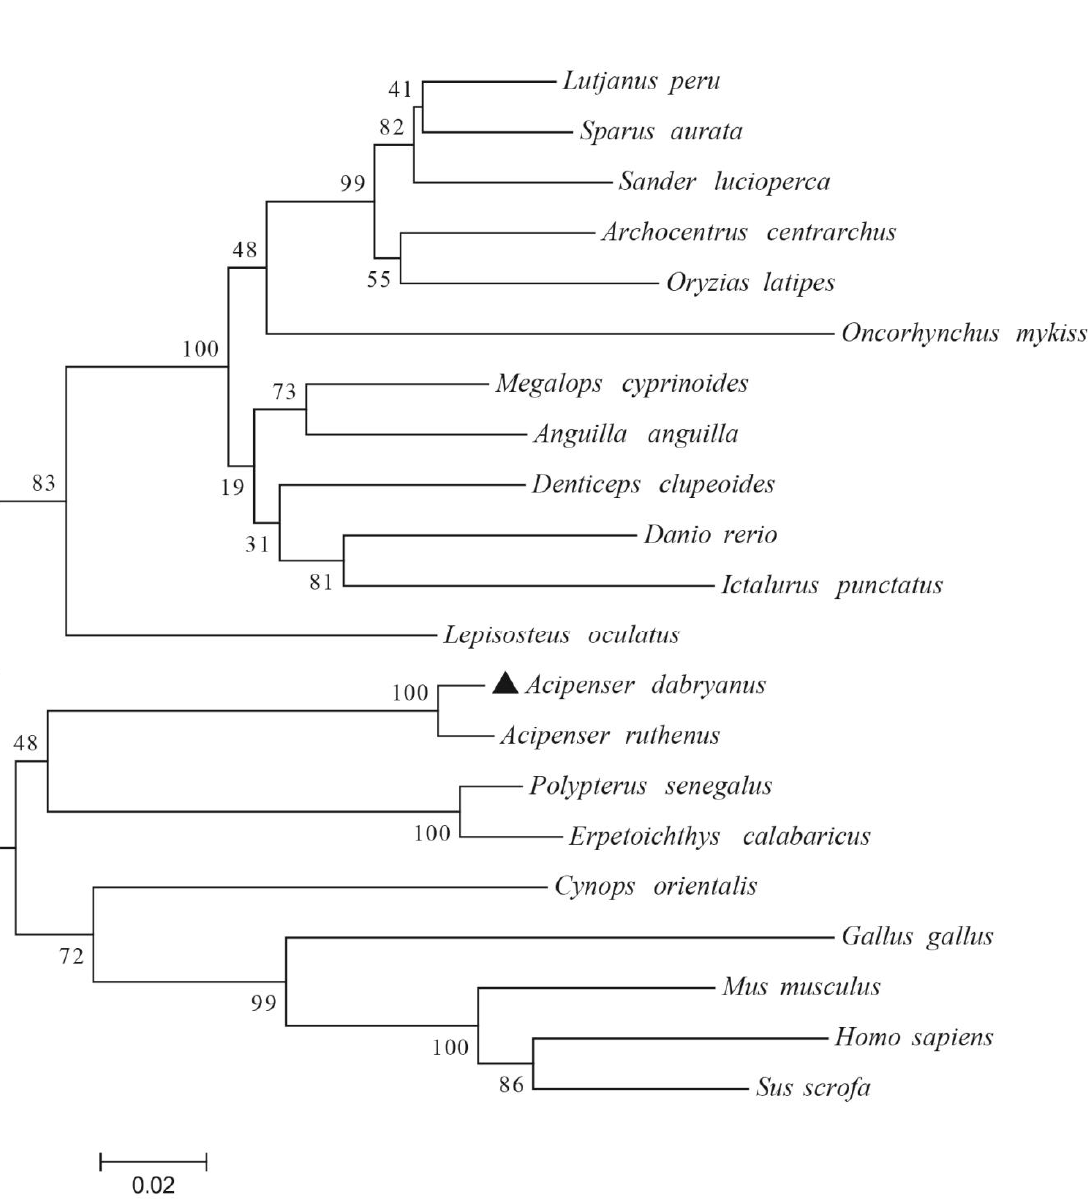
Figure 5. Phylogenetic tree of the amino acid sequence of the AdCAT protein. (cid:78) was used to highlight Acipenser dabryanus.